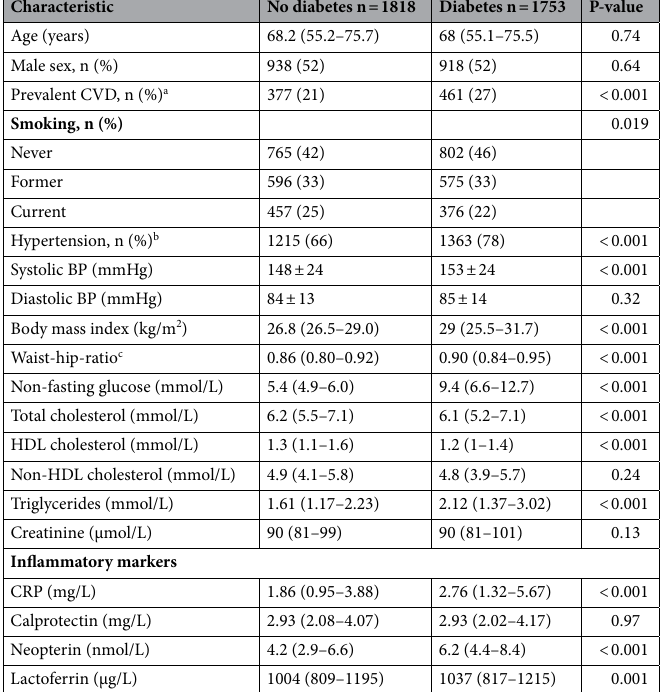
Table 1. Baseline characteristics of the study population according to diabetes status. Data are given as medians (interquartile range), means ± standard deviation or proportions (%). CVD Cardiovascular disease, BP Blood pressure. a Self-reported history of myocardial infarction, angina pectoris or stroke. b Systolic BP of ≥ 140 mmHg or diastolic BP of ≥ 90 mmHg or self-reported use of antihypertensive medication. c Information on waist-hip-ratio was available in 3556 individuals (1740 with diabetes and 1816 without